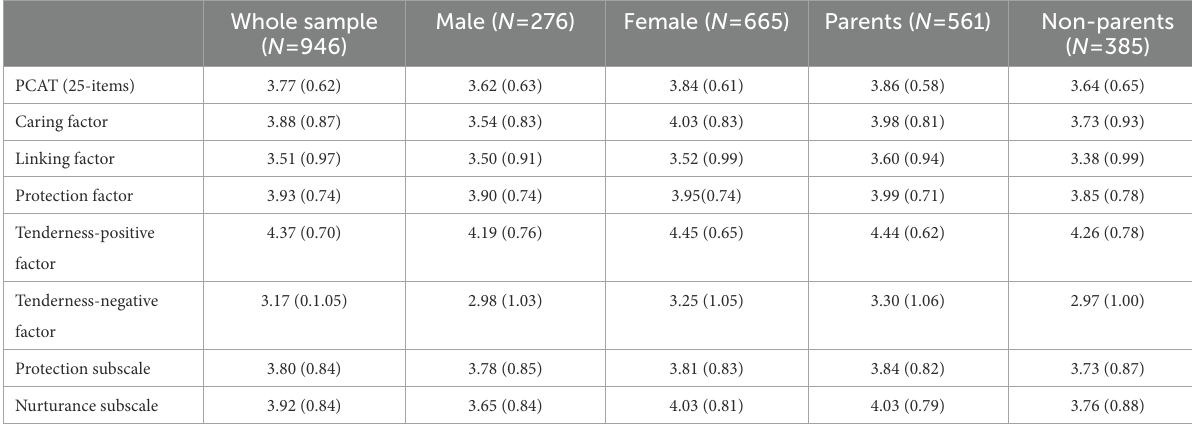
TABLE 3 Means and standard deviations (in